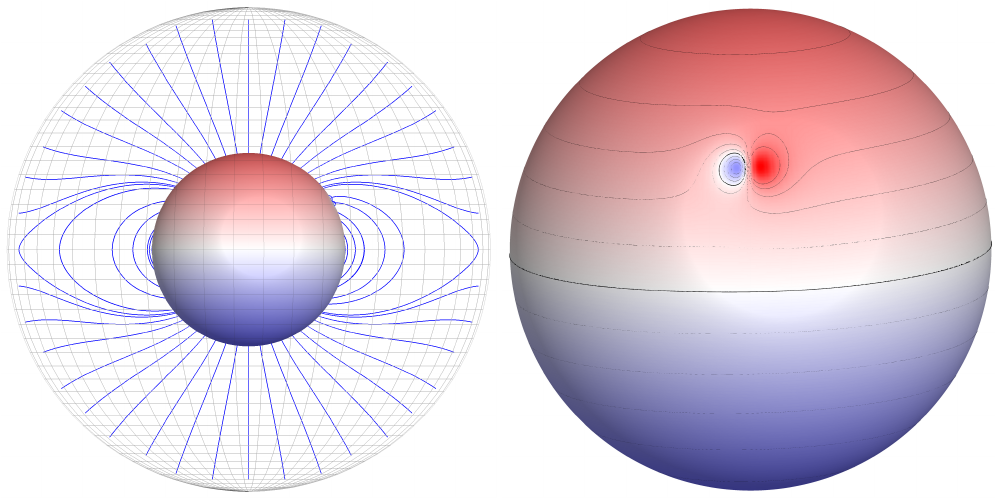
Fig. 3. Source surface model of the solar magnetic field. Left panel: The field lines outline the global dipole field structure, and the source surface is indicated by a gray wire mesh. The color shading of the solar sphere corresponds to the radial magnetic field strength. The magnetic bald patch shown in the right panel of Fig. 2 is located at the east limb around 30 ◦ northern latitude. Right panel: Same magnetic configuration, this time showing the bipolar structure that gives rise to the bald patch. The thin black lines represent iso-contours of the radial magnetic field, the thick black lines are the polarity inversion lines (PIL, B r =